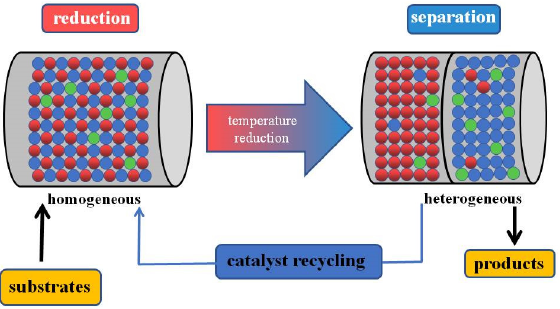
Figure 6. TMS catalyst recycling concept [74].